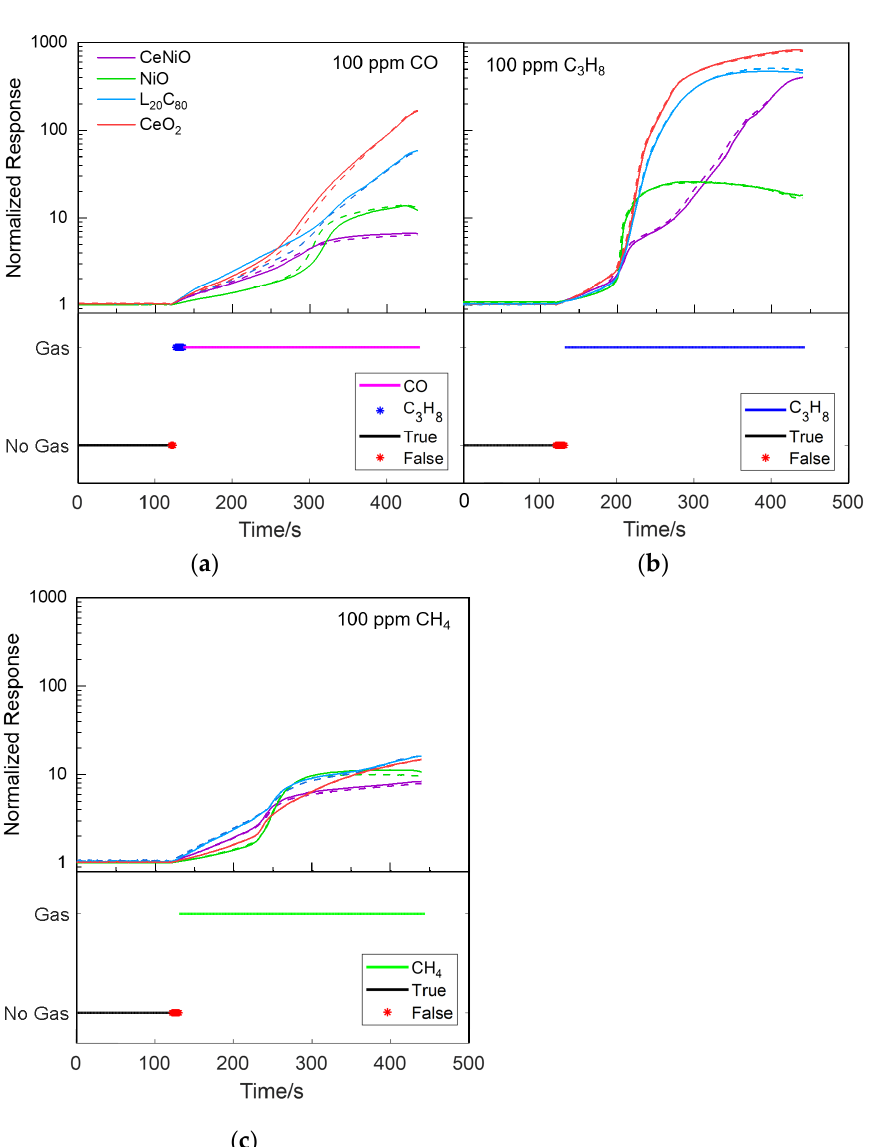
14 of 18 Figure 9. Cross-validation result: classification accuracy of ( a ) 100 data points per sample; ( b ) 40 data points per sample. 5.2. External Validation of CLSTM Neural Network Model To further demonstrate the capability of CLSTM neural network model for potential real-time predications, we conduct the external validation analysis by using one addi- tional set of sensor array response data towards 100 ppm CO, 100 ppm C 3 H 8 and 100 ppm CH 4 , respectively. Prior to the analysis, the CLSTM model is well re-trained offline upon all data utilized in preceding section, where 40 data points (2 s) are included in each time- series sample. The additional validation dataset is experimentally acquired at a different time, which is inevitably subject to the ambient and measurement variations. Such varia- tions further result in the discrepancy between the training and validation datasets as shown in Figure 10. For this reason, these two datasets are statistically independent and thus can be readily used for the external validation analysis. The prediction results are listed in Table 4. As can be seen, only a very small number of misclassifications are cap- tured, most of which occur right after the reducing gas introduction (Figure 10). Recall that each sample lasts 2 s with 0.5 overlapping ratio. The misclassification number (3rd column of Table 4) clearly illustrates that the model is capable of identifying gas species correctly starting from 13 s upon the exposure and throughout the entire transitional phase. It is not surprisingly found that the CLSTM appears to be a bit delay in response towards reducing gas exposure because it falsely identifies “No Gas” class at the initial stage of exposure. On the other hand, C 3 H 8 becomes a more dominant interference than “No Gas” class in CO testing scenario. Overall, the external validation results demonstrate the excellent capability of CLSTM in differentiating/identifying different gas species at early stages. To further enhance the early-stage gas identification capacity to suit the practical real- time application, the fundamental study needs to be continuously conducted in order to create a sensor array with improved selectivity and sensitivity with respect to the target gases. Additionally, the efficient and effective signal processing technique can be incor- porated to extract the pivot differentiable features from the raw data, which facilitates the